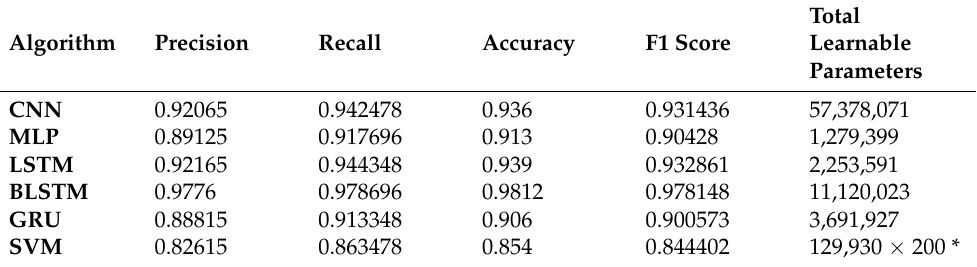
Table 4. Test Performance of the Final Tuned Identity Models.